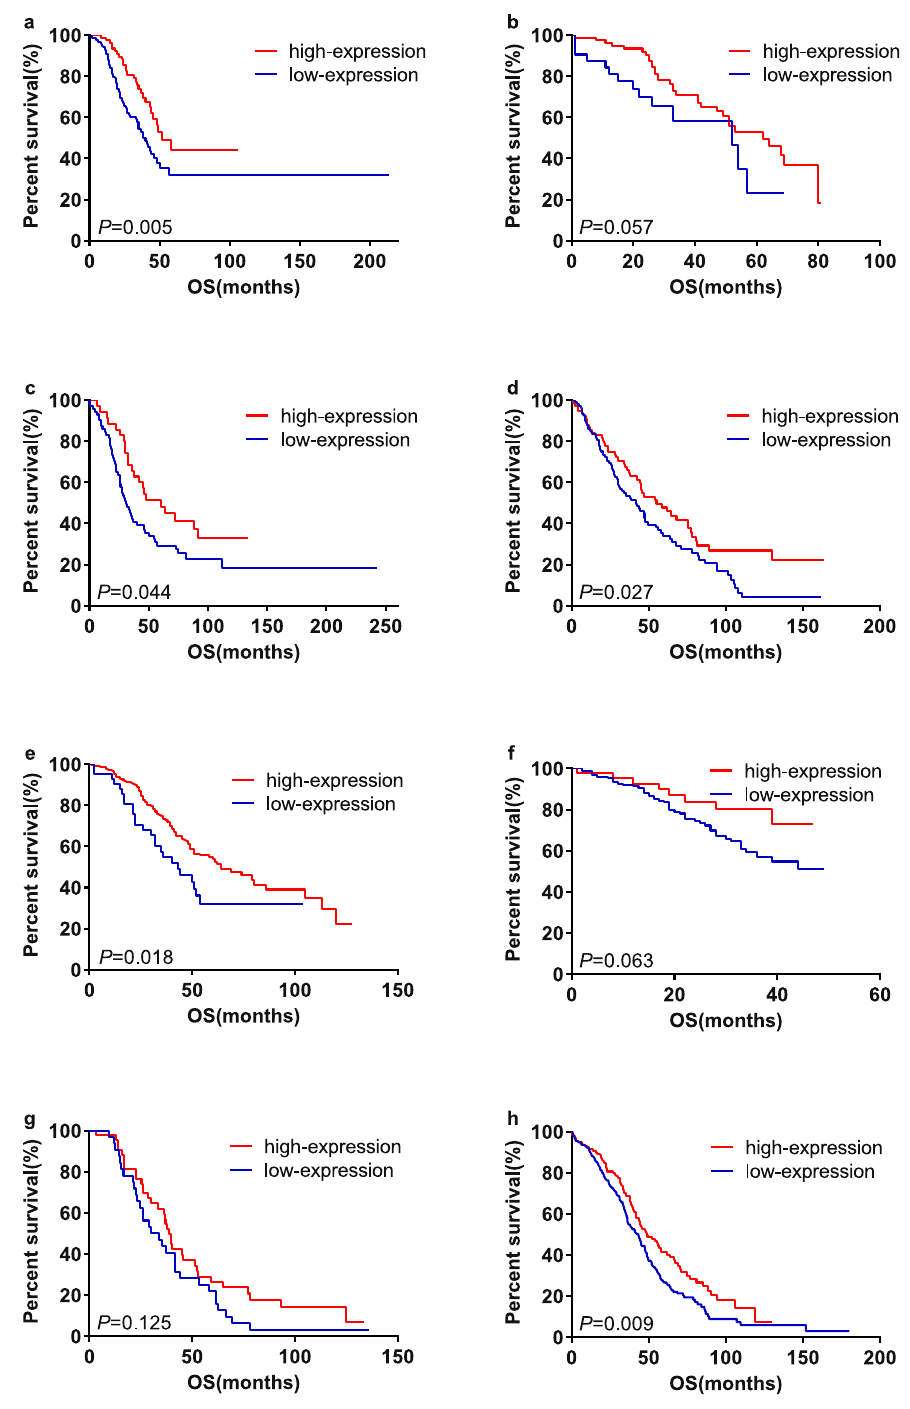
Figure 2. High mRNA expression level of IL-6R in ovarian cancer patients was associated with better prognosis. ( a ) Kaplan-Meier analysis of dataset GSE9891. ( b ) Kaplan-Meier analysis of dataset GSE17260.( c ) Kaplan-Meier analysis of dataset GSE26193. ( d ) Kaplan-Meier analysis of dataset GSE26712. ( e ) Kaplan-Meier analysis of dataset GSE32062. ( f ) Kaplan-Meier analysis of dataset GSE49997. ( g ) Kaplan-Meier analysis of dataset GSE63885. ( h ) Ovarian cancer data from TCGA